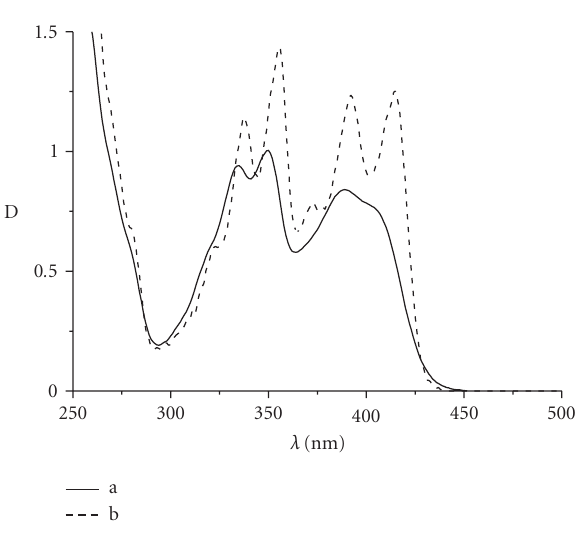
Figure 1: The absorption spectra of III in ethanol at 295 K (a) and 77 K